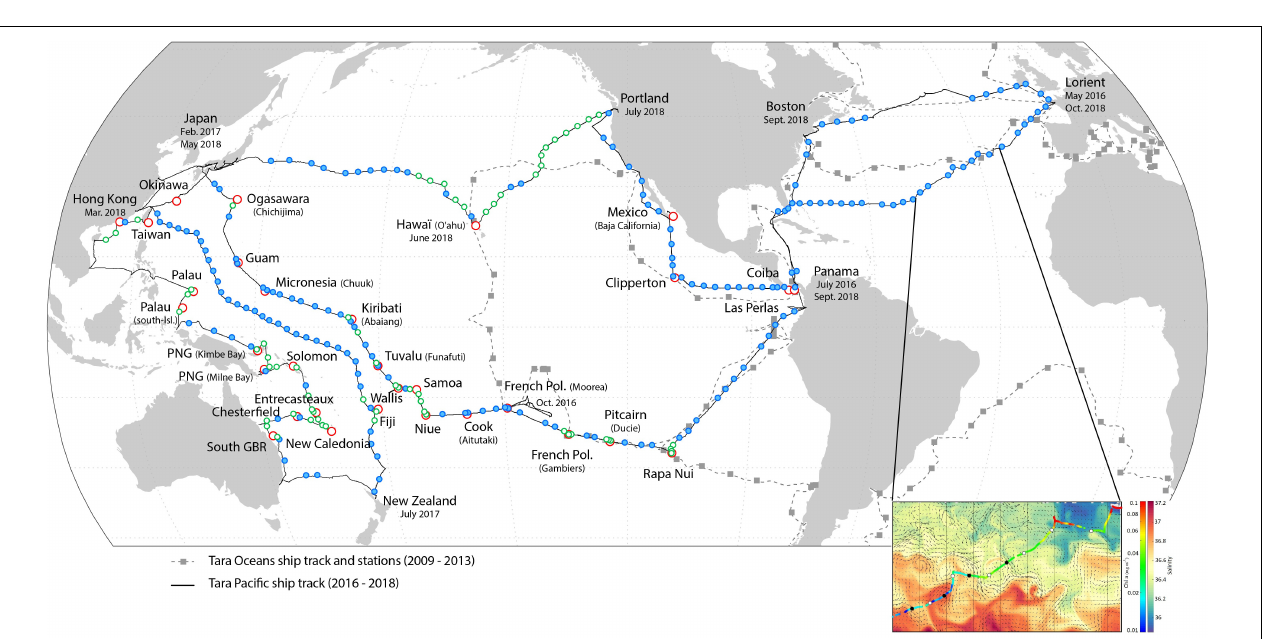
FIGURE 1 | Sailing track of the Tara Pacific expedition showing seawater temperature measured by the thermosalinograph, and the 32 coral islands studied as part of the expedition (Planes et al., 2019). Sections of the expedition where some of the instruments were not functioning are underlined as follows: continuous black line – hyperspectral absorption and attenuation sensor, discontinuous line – Equilibrator Inlet Mass Spectrometer and dotted line– CDOM fluorometer.